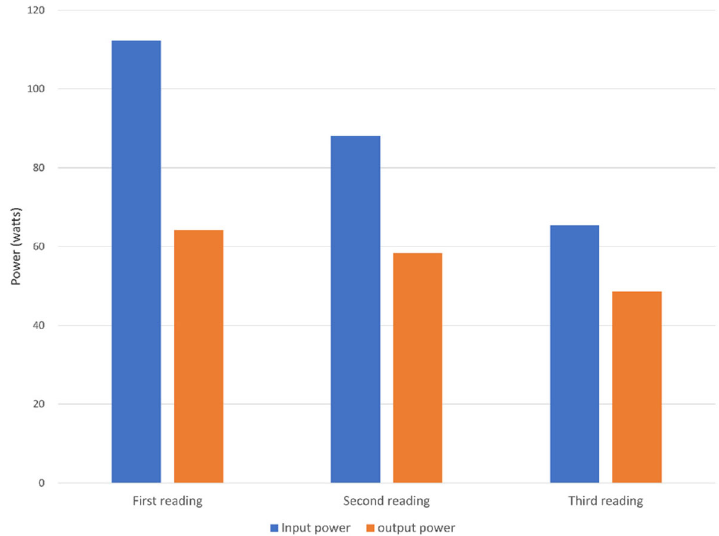
Fig. 9 Input and output power: when conventional PWM charge controller is